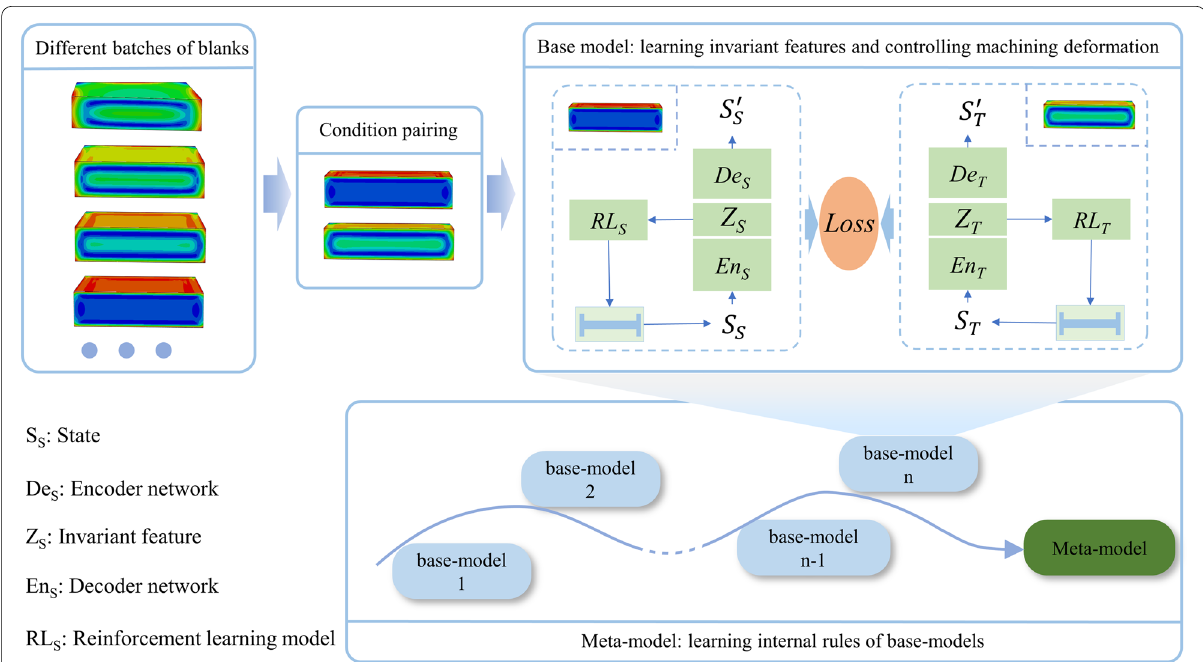
Fig. 3 Learning framework of reinforcement learning method for machining position adjustment strategy based on meta-invariant feature